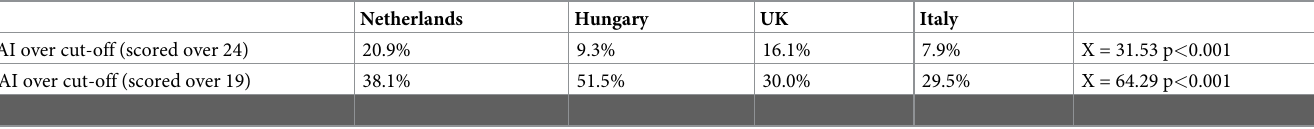
Table 3. Exercise Addiction Inventory (EAI) and Appearance Anxiety Inventory (AAI) results per country.